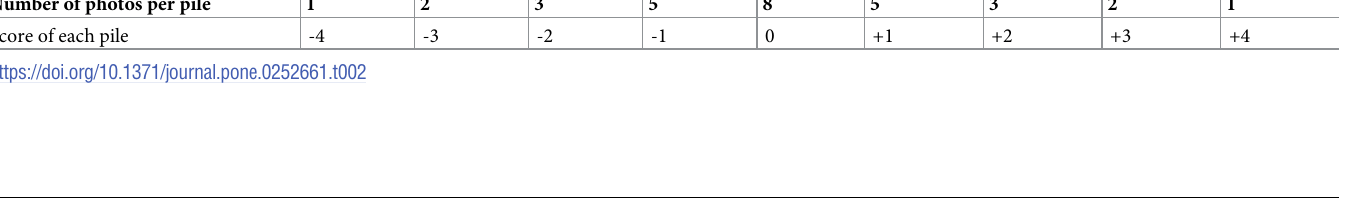
Table 2. The Q sort distribution is designed briefly based on a normal distribution. Number of photos per